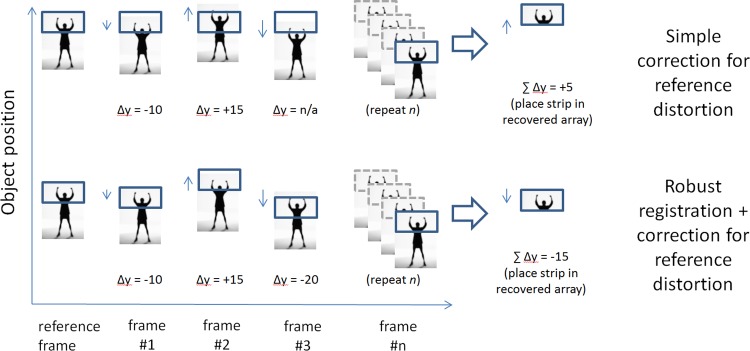
Depiction of two strategies to place rectangular strips in the correct position to minimize intra-frame distortion.Top: a simple procedure in which each strip in the reference frame is compared to the corresponding strip, relative to the beginning of the frame, in each other frame of the sequence. Here no special effort is made to locate the corresponding anatomy; when displacement becomes too great (frame #3), the displacement cannot be recovered or can be recovered only poorly, leading to a divergence between the methods for larger displacements. Bottom: As for top, but now a robust registration procedure is used which ensures that the corresponding anatomy is correctly located, if present in the imaged field.